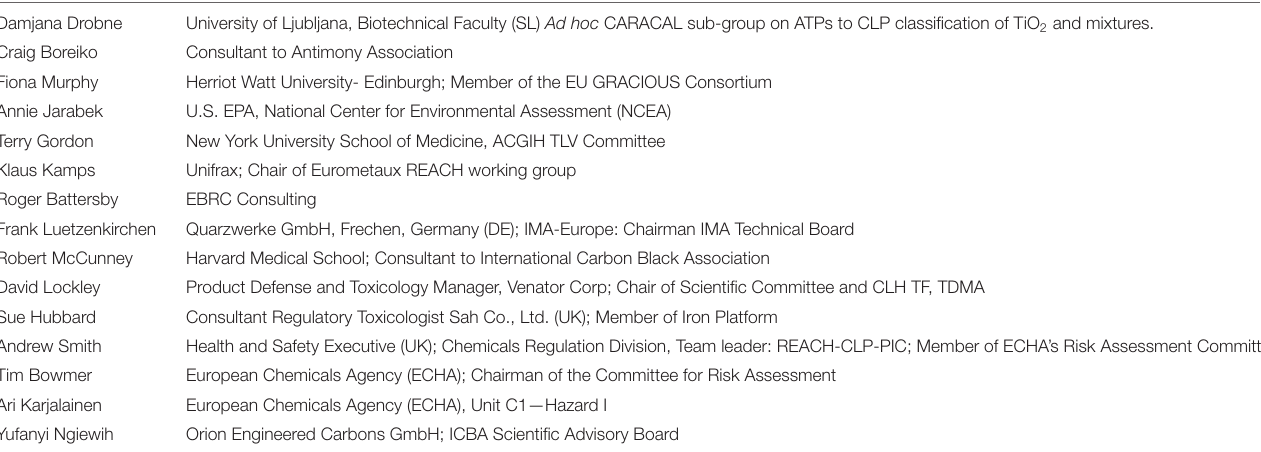
TABLE 2B | Edinburgh Workshop